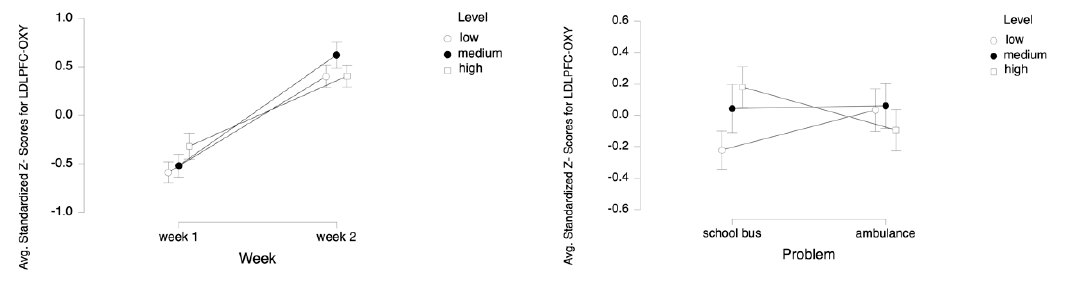
Figure 10. Line plots represent interaction effects of Level and Week (left) and Level and Problem (right) on average stand- ardized z scores for oxygenation for left dorsolateral prefrontal cortex (Z-LDLPFC_OXY) with the error bars representing the standard error of the mean statistic. Differences in average oxygenation Z-LDLPFC_OXY are represented across low, medium, and high cognitive load tasks for Week 1 and Week 2 and for School Bus and Ambulance problem scenarios.